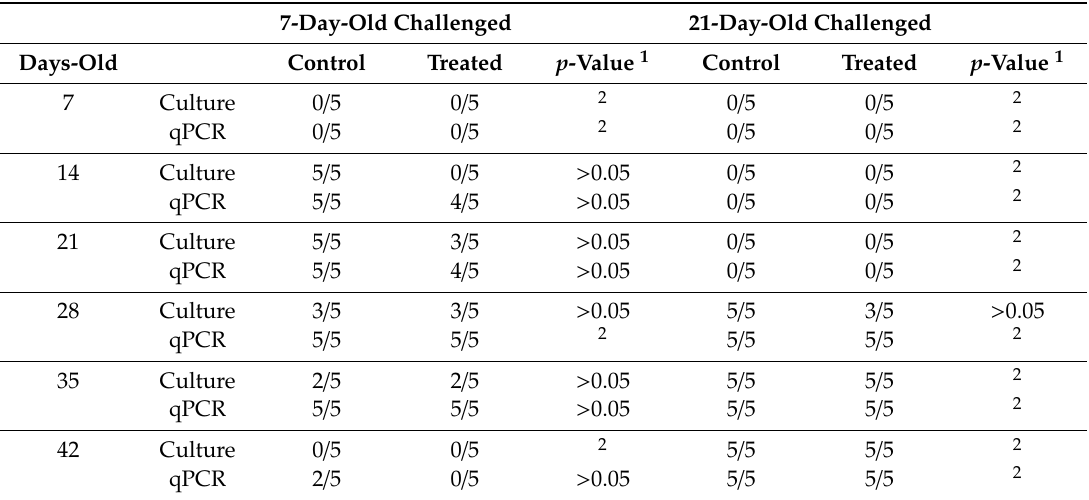
Table 4. Number of animals testing positive for Salmonella spp. by culture and qPCR.